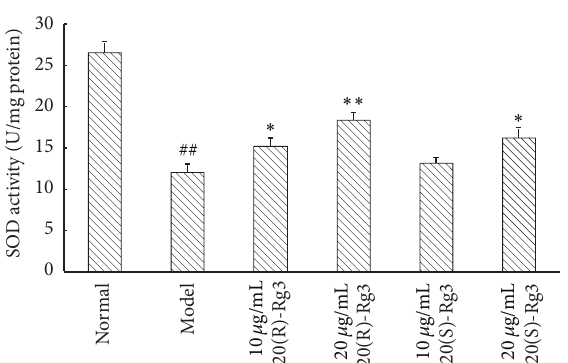
Figure 7: Ginsenoside Rg3 increased the SOD activity in SK-N-SH cells. ## 𝑃 < 0.01 versus normal group, ∗ 𝑃 < 0.05 , and ∗∗ 𝑃 < 0.01 versus model group.